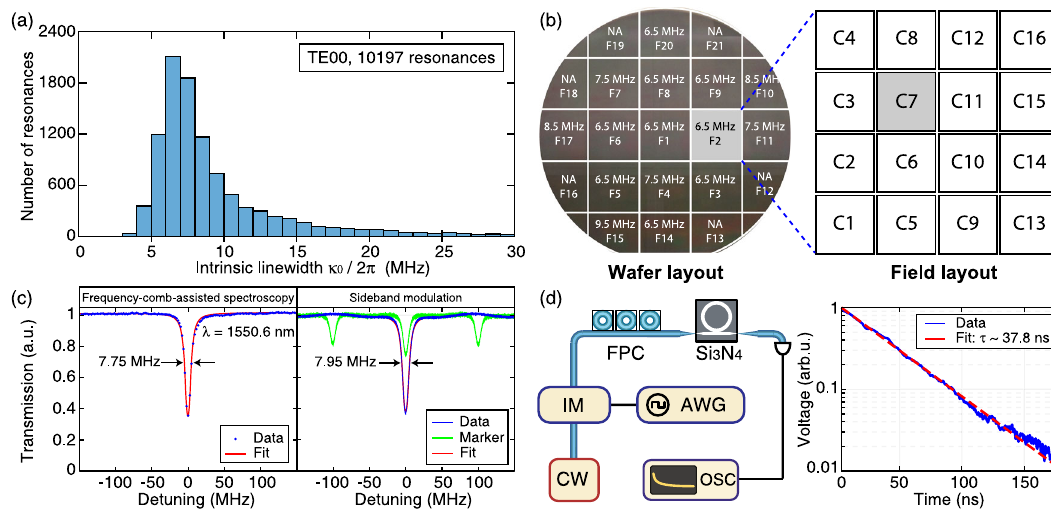
Fig. 3 Statistical study of microresonator Q factors using multiple techniques. a Histogram of 10,197 TE 00 resonances from twenty-six microresonators, showing the most probable value of κ 0 /2 π = 6.5 MHz and Q 0 = 30 × 10 6 . b DUV stepper exposure layout, and the most probable value κ 0 /2 π of the C7 chips at different positions on the wafer. The reticle design containing sixteen chips is uniformly exposed in discrete fi elds over a 4-inch wafer. NA: not applicable, due to visible photoresist coating defects or missing C7 chips near the wafer edge. c Linewidth measurement of the same resonance at 1550.6 nm using frequency-comb-assisted diode laser spectroscopy (left, κ /2 π = 7.75 MHz and κ 0 /2 π = 5.87 MHz) and sideband modulation technique (right, κ / 2 π = 7.95 MHz and κ 0 /2 π = 6.05 MHz). This resonance does not present a visible mode split. d Cavity ring-down measurement. An intensity modulator (IM) is used to switch off the pump fi eld. The cavity ring-down signal is averaged 1000 times. The exponential fi t gives an optical fi eld decay time of τ = 37.8 ns, corresponding to a photon decay time of 18.9 ns and a loaded linewidth of κ /2 π = 8.4 MHz. arb.u: arbitrary unit, AWG: arbitrary function generator, OSC: oscilloscope, CW: continuous-wave laser, FPC: fi ber polarization